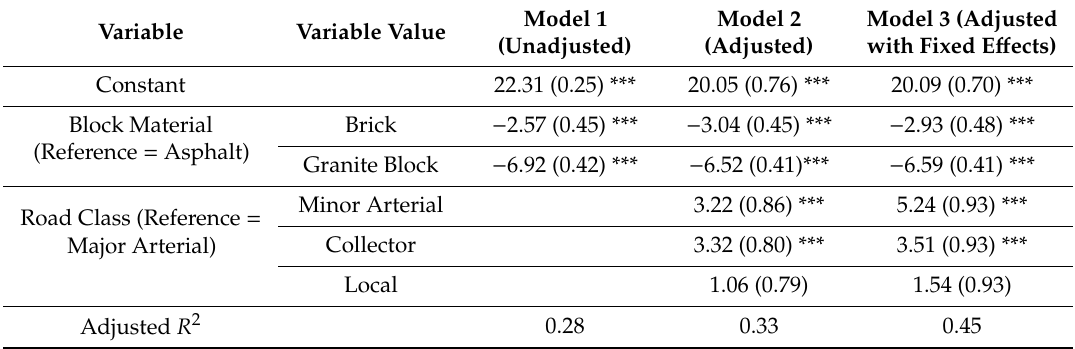
Table 3. Results of linear regression of vehicle speed (unstandardized coe ffi cients are reported with standard errors in parentheses; *** p < 0.005).